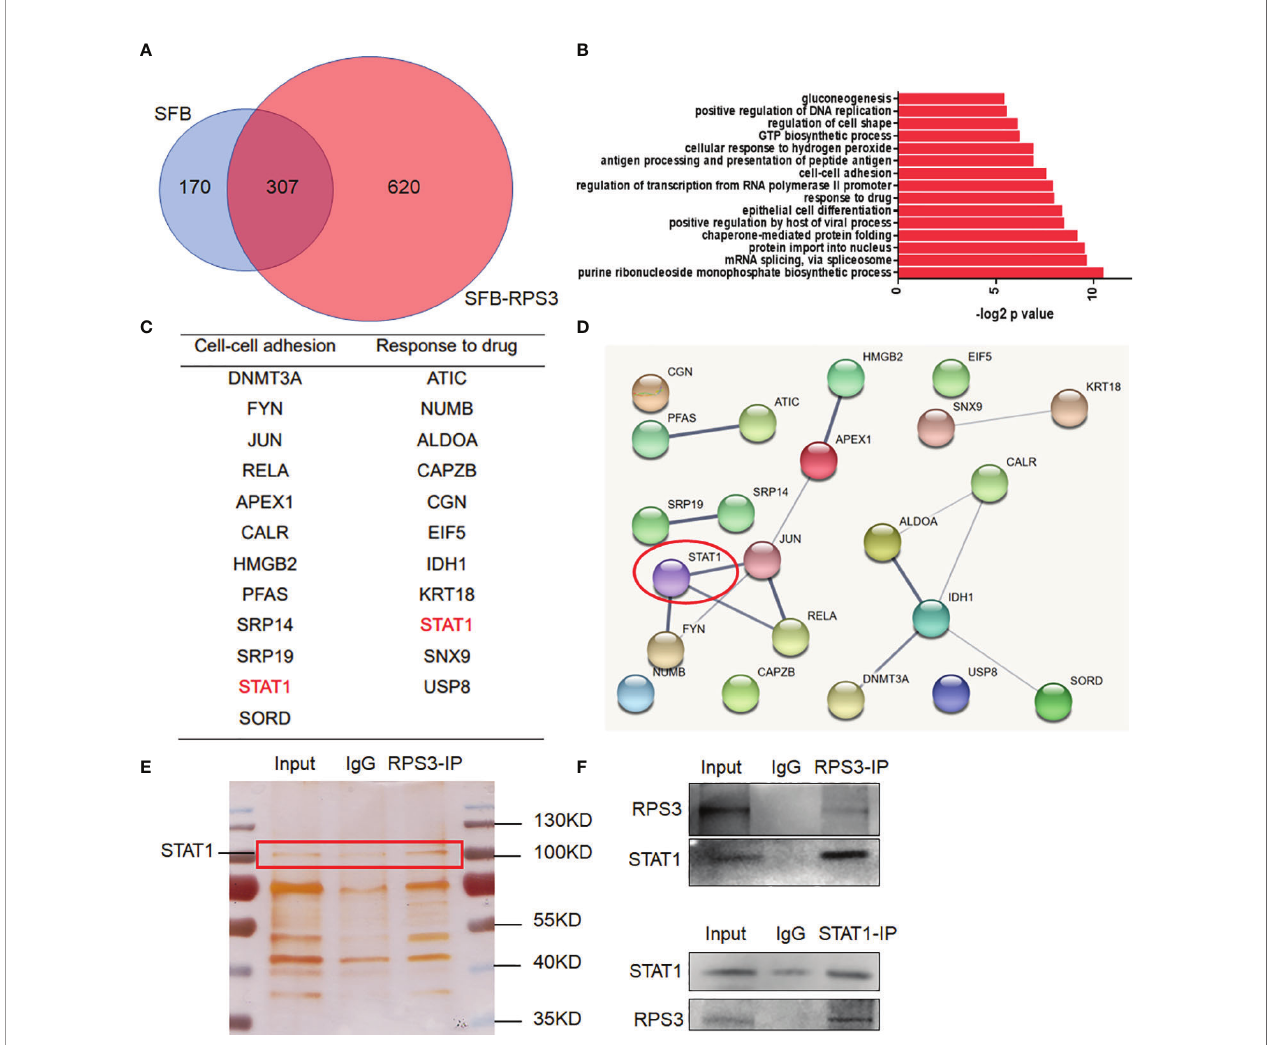
FIGURE 4 | RPS3 interactedwith STAT1. (A) A total of 620 differentially expressed proteinsspeci fi cally bound to RPS3. (B) GO analysisof the differentially expressed genes. (C) Related proteinswere enriched among pathways associated with migration,invasion anddrugsensitivity. (D) The interconnectionsbetween related genes. (E) Silver stainingexperiments con fi rmed the mutual binding of RPS3 and STAT1. (F) IP experiments con fi rmed the mutual binding of RPS3 and